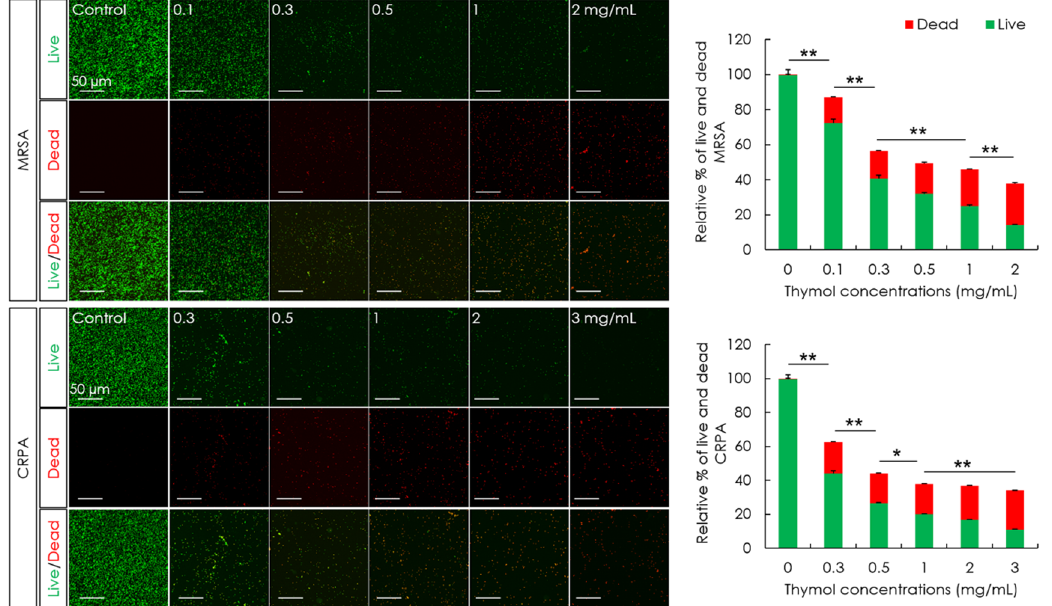
Figure 1. The effects of thymol on the viability of methicillin-resistant Staphylococcus aureus (MRSA) and ciprofloxacin-resistant Pseudomonas aeruginosa (CRPA). MRSA and CRPA viabilities were examined following 24 h exposure to different concentrations of thymol. Thymol promoted significant concentration-dependent reductions in live MRSA and CRPA cells (green), and increases in dead MRSA and CRPA cells (red). Data are shown as the means ± standard errors of the mean of five independent experiments (** p < 0.01; * p < 0.05).